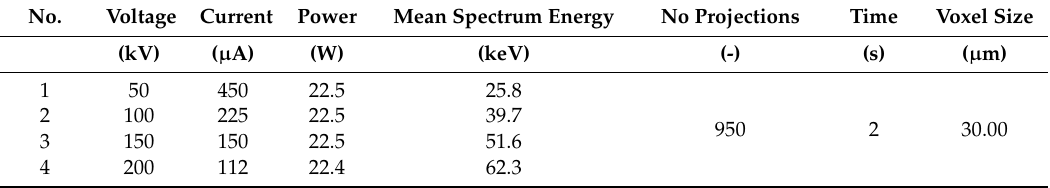
Table 5. XCT parameters used in the experiment. Mean spectrum energy estimated using SpecCalc [52].